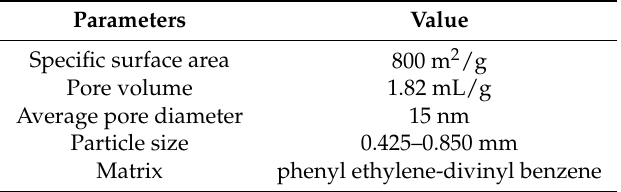
Table 1. Properties of XAD-16HP